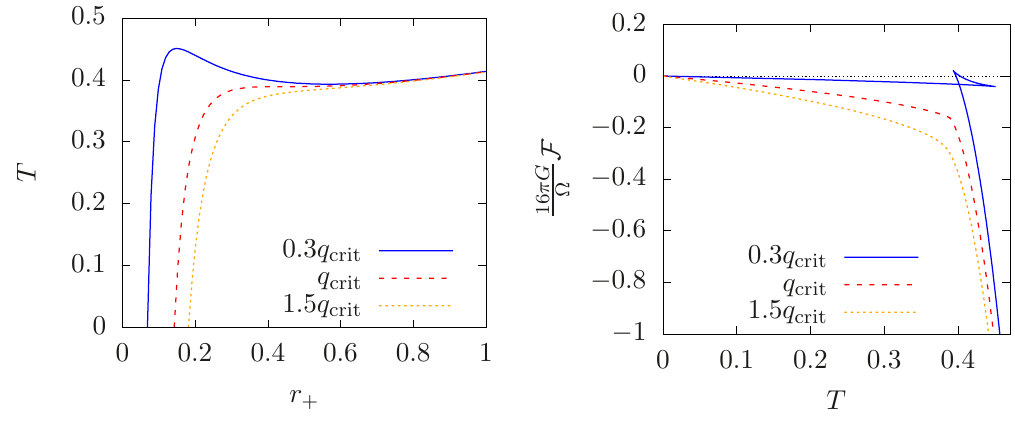
Figure 1 . Plots of T vs. r + (left) and vs. T (right) for the case n = 0 : 6, (cid:23) = 0 : 3, L 2 = ‘ 2 = 2, F and D = 4. In this case, the critical charge has the value q crit = 0 : 0588.